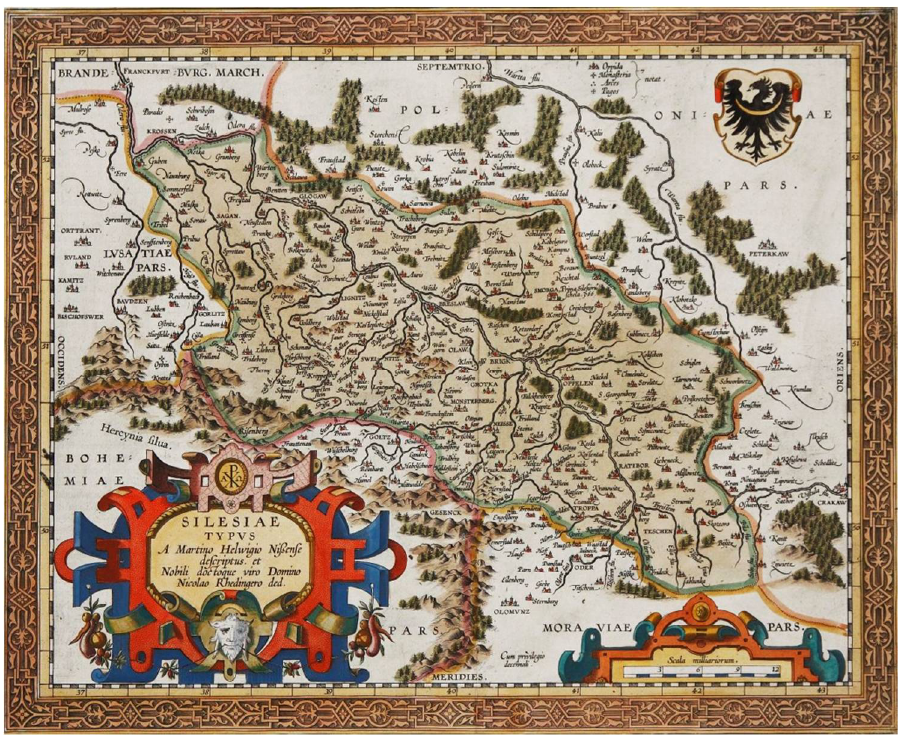
Figure 2. Map of Silesia from the end of the 16th century according to A. Ortelius. Theatrum Orbis Terrarum, Antverpiae, 1592. Source: Polona (1592), National Library Poland.